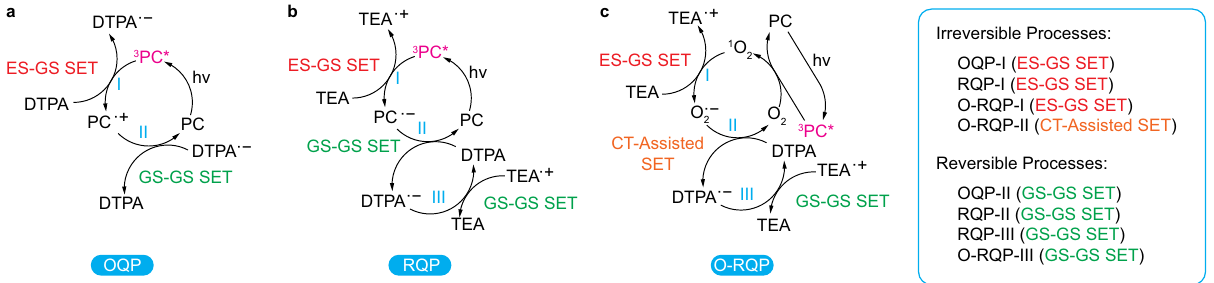
Fig. 3 Categories of electron transfer steps. a – c Nature of each electron transfer step in OQP ( a ), RQP ( b ) and O-RQP ( c ) catalytic cycles. OQP oxidative quenching pathway, RQP reductive quenching pathway, O-RQP oxygen-mediated reductive quenching pathway, ES – GS SET single electron transfer from an excited state to a ground state, GS – GS SET single electron transfer between two ground states, CT-assisted SET single electron transfer assisted by